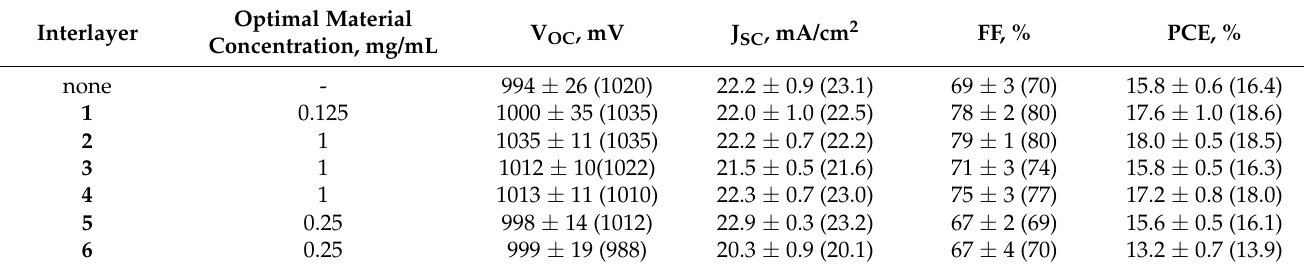
Table 2. Characteristics of the solar cells, using derivatives 1 – 6 as interlayers (champion device characteristics are given in brackets).